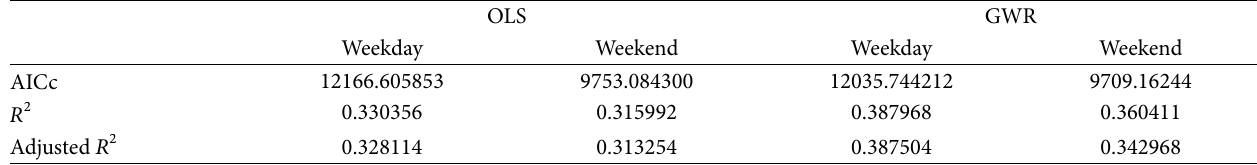
Table 4: Comparison between global model and the GWR